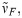
Sensitivity regarding the education, marriage reconsideration and premarital screening rates with respect to thalassemia major population in both genders.(a) Sensitivity of ϵ, νF, ν˜F, and αsF with respect to TF. (b) Sensitivity of ϵ, νM, ν˜M, and αsM with respect to TM. Note that ε is the education rate, νK and ν˜K the marriage reconsideration rates of uneducated and educated carrier populations, respectively, and αsK is the premarital screening rate. The inner plots in (a) and (b) are the enlargement of sensitivity regarding ϵ, νK, and ν˜K, where K = {M, F}.